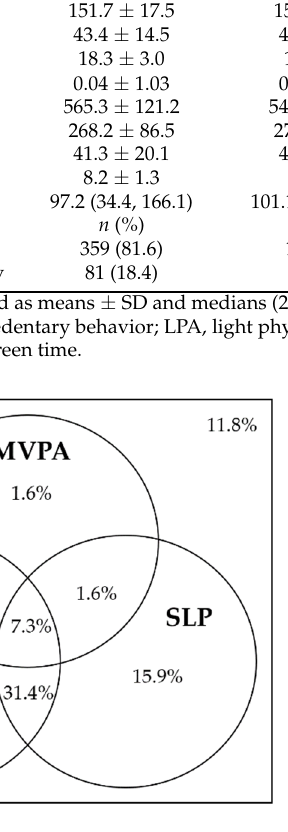
Figure 2. Proportions of Chinese children and adolescents meeting 24-Hour Movement Guidelines.